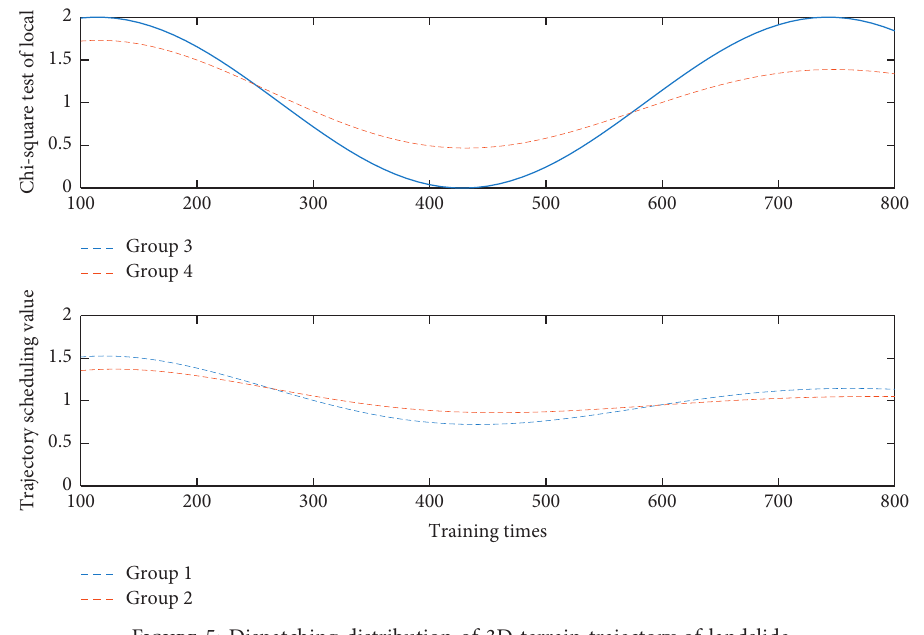
Figure 5: Dispatching distribution of 3D terrain trajectory of